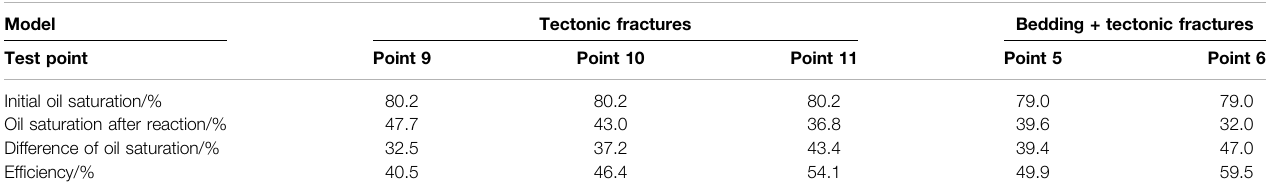
TABLE 2 | Comparison of oil saturation changes before and after the